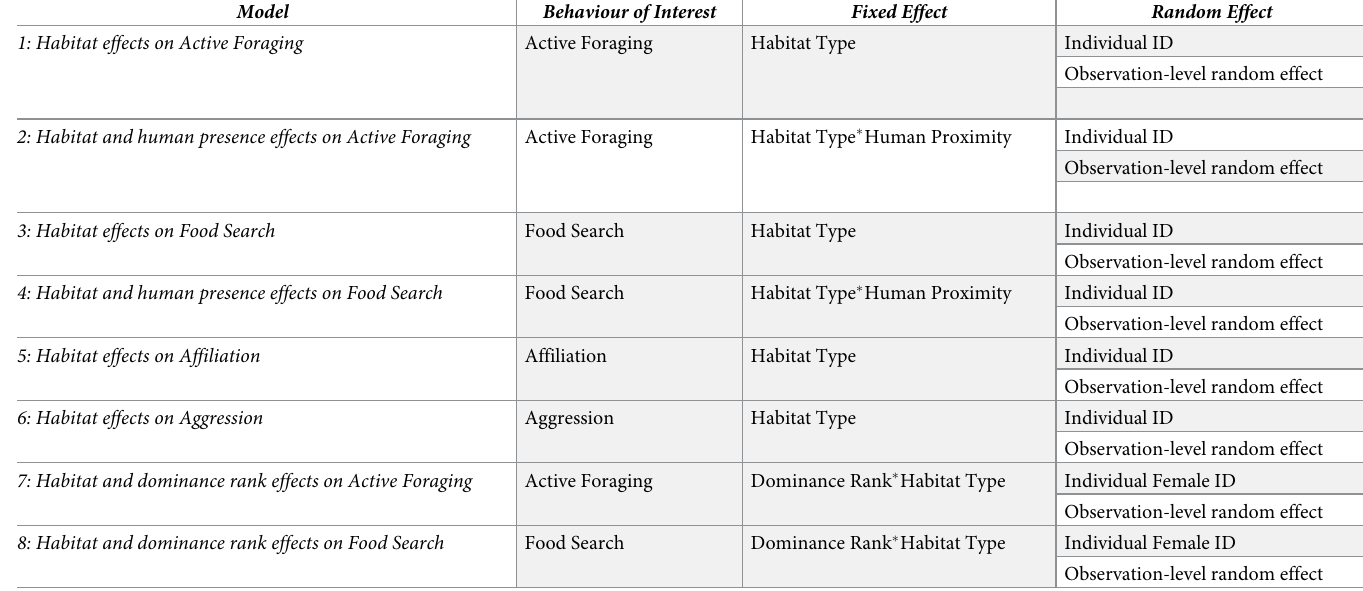
Table 1. Selected models and model parameters for the generalised linear mixed-effect